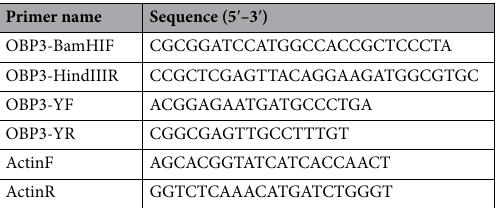
Table 1. Primers used for prokaryotic expression and quantitative RT-PCR of OBP3